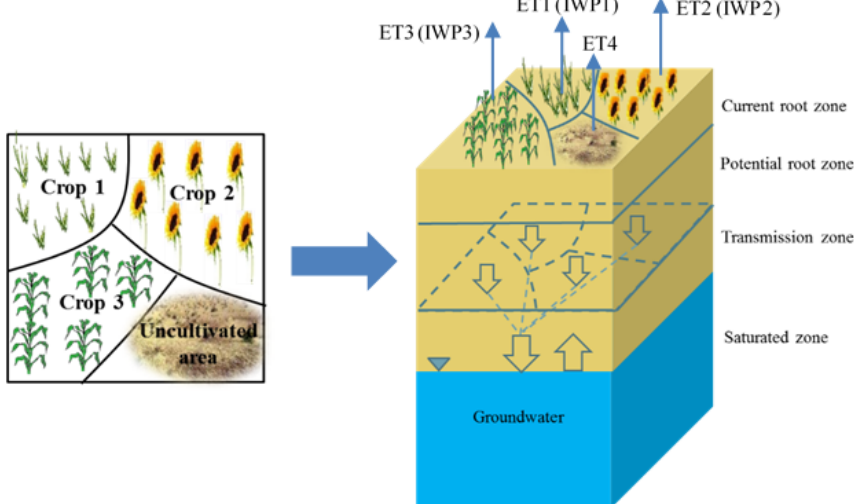
Figure 3. Schematic diagram of coupling soil water and salt dynamics and groundwater level and salinity. The IWP evaluation in each HRU is also shown.